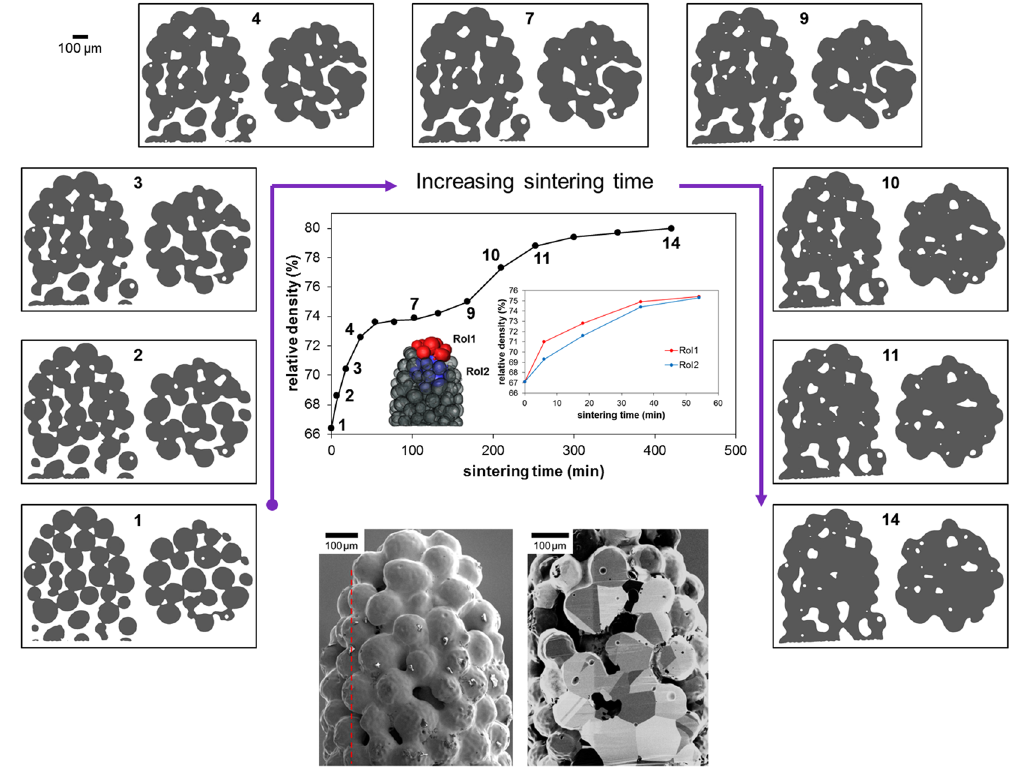
Figure 1. Densification of the powder body across the sintering steps at 1050 °C. Centre: Plot showing the change in density for the full sample and, inset, comparing two regions of interest (RoI) for the first 5 steps. The locations of these local RoI’s with respect to the sample are indicated in the 3D surface rendering (semi transparent) of the full sample; one from the top of the sample (RoI1, red) and one from within the centre of the sample (RoI2, blue). Shown alongside are pairs of virtual slices (left: vertical and right: horizontal slices) from the 3D renderings for selected steps reconstructed from the absorption tomography. A FIB-milled section of the final sintered sample is shown below-right, and its location in the sample is indicated by the dashed red line in the SEM image of the full sample